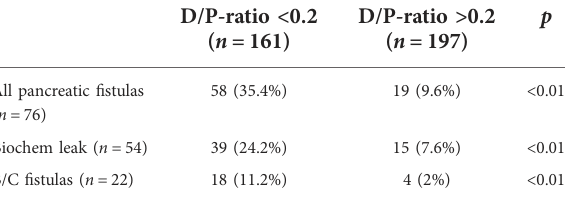
TABLE 2 Preoperatively estimated D/P ratio <0.2 correlates signi fi cantly with the risk of POPF